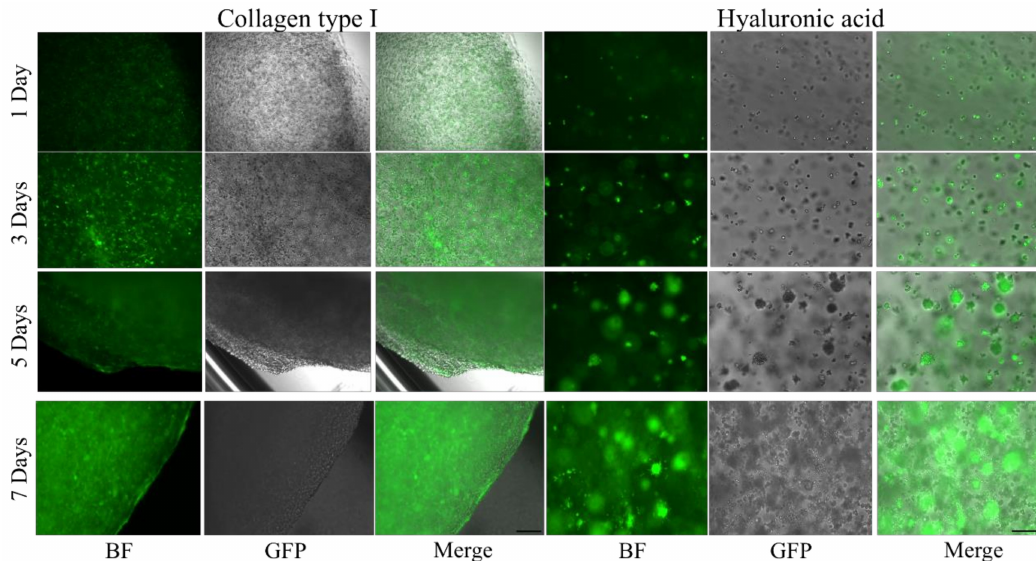
Figure 6. Cell morphology and spatial distribution. Morphology and spatial distribution of U87-MG cells, within the two di ff erent sca ff olds, were examined via fluorescent microscopy at several time points, namely at 1, 3, 5, and 7 days post inclusion. Scale bar = 100 µ m.